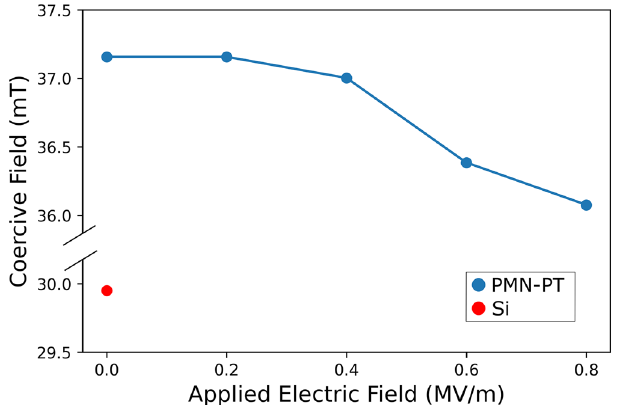
Figure 6. Median coercive field as a function of the applied electric field to the PMN-30PT and Si substrates. Line drawn to aid reader’s eyes.